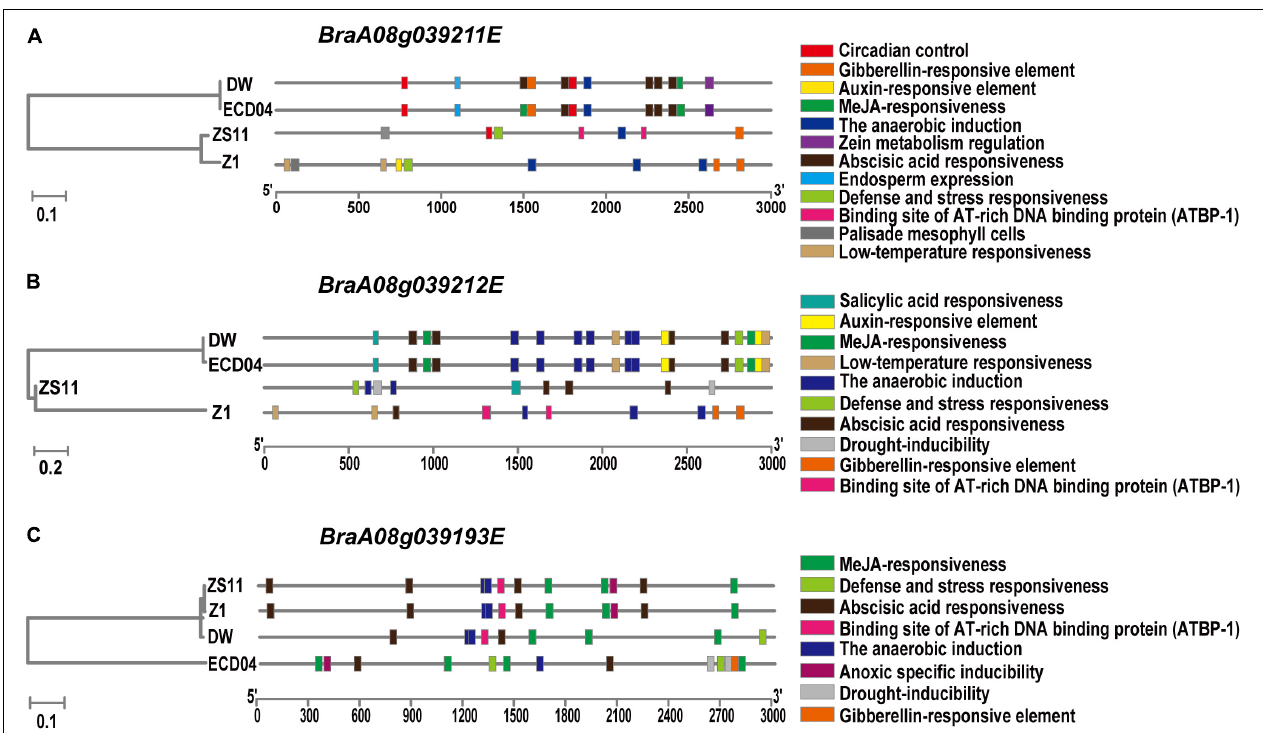
FIGURE 6 | Analysis of cis -acting elements in promoter region of the homologs of BraA08g039211E (A) , BraA08g039212E (B) , and BraA08g039193E (C) between resistant (DW and ECD04) and susceptible (ZS11 and Z1/HZSX)